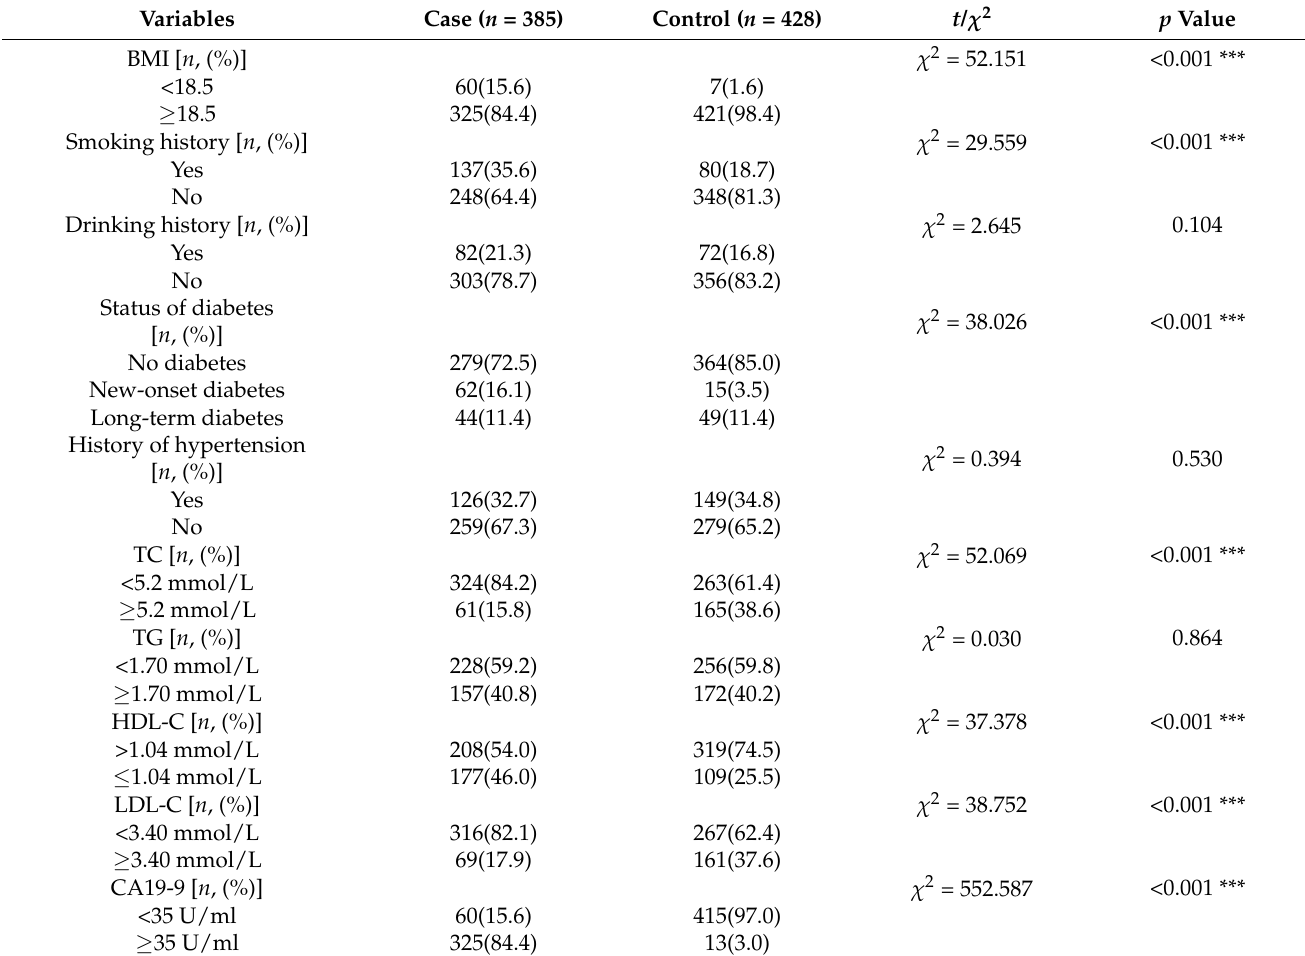
Table 2. Univariate analysis of risk factors for PC.